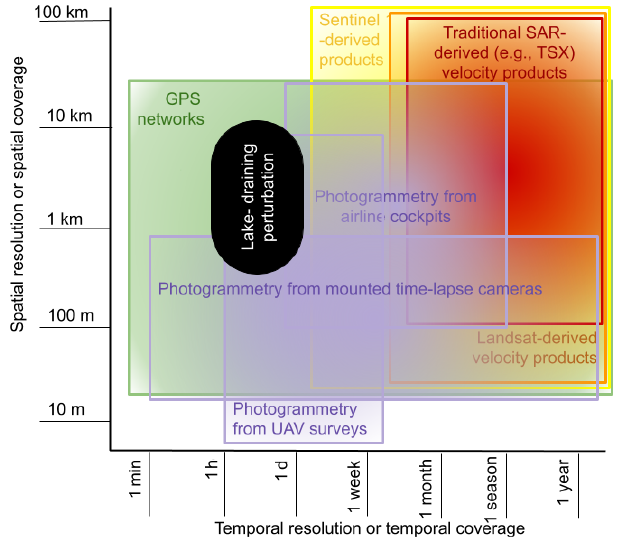
Figure 13. Illustration of the rough spatial and temporal resolutions of candidate methods and datasets (colors) evaluated here for re- solving hypothesized lake drainage precursor events (black) at the regional